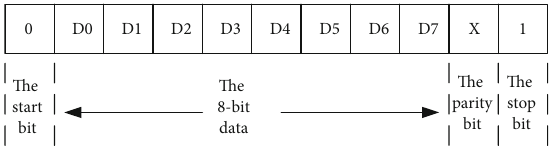
Figure 3: Format of single-byte